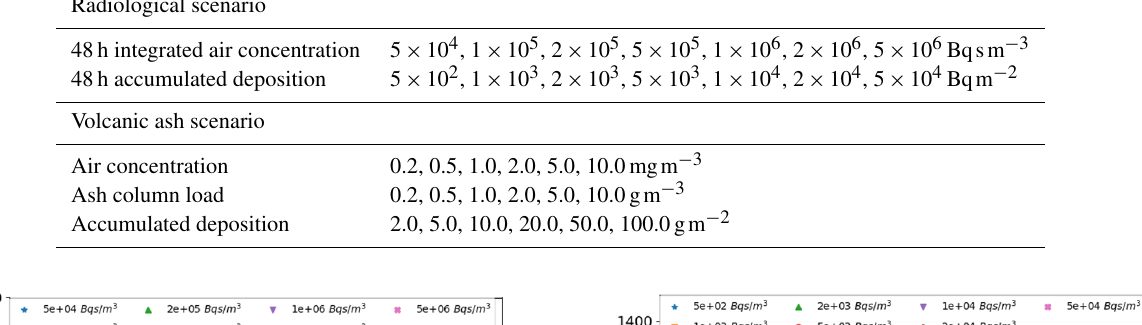
Table 1. Thresholds used in the assessment of forecast skill for each of the quantities’ output from the radiological and volcanic ash scenarios. Radiological scenario